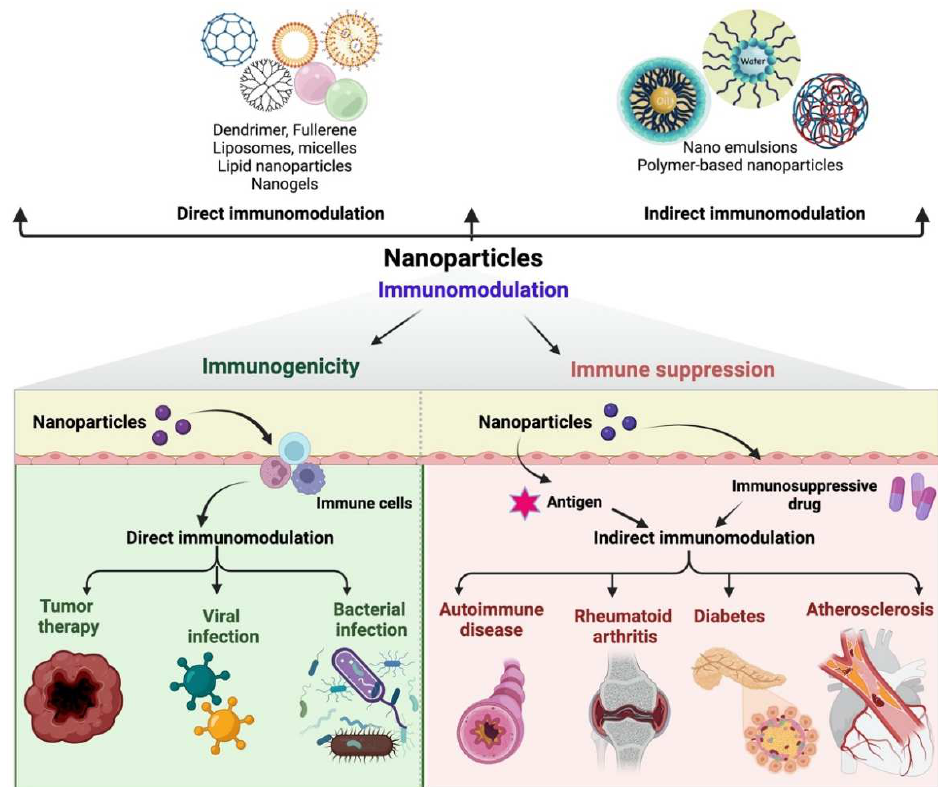
Figure 2. Nanomaterials for indirect and direct immunomodulation. NMs serve as a carrier, and by releasing an immunosuppressive medication or antigen, the immune response is modulated indirectly. Interaction between NMs and IS is a form of direct immunomodulation.